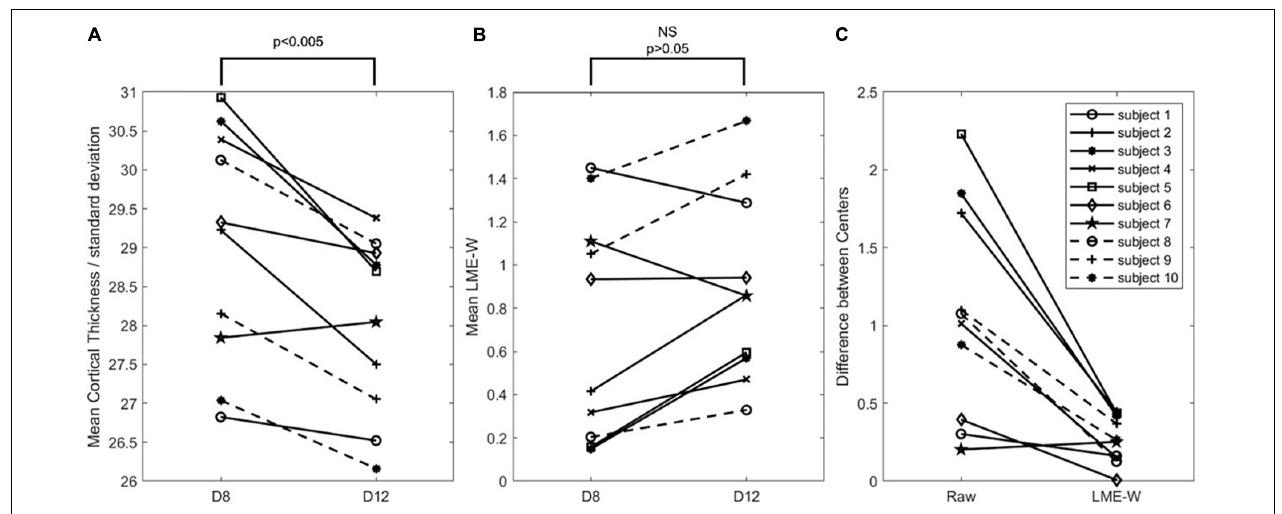
FIGURE 3 | Intrasubject comparison of Raw and LME-W. (A) Spaghetti diagram showing mean cortical thickness of each dataset divided by standard deviation of cognitive normal subjects of D8. (B) Spaghetti diagram showing mean the LME-based W-score of each dataset. (C) Spaghetti diagram showing the difference between two centers of before and after the harmonization. Abbreviations: NS, not